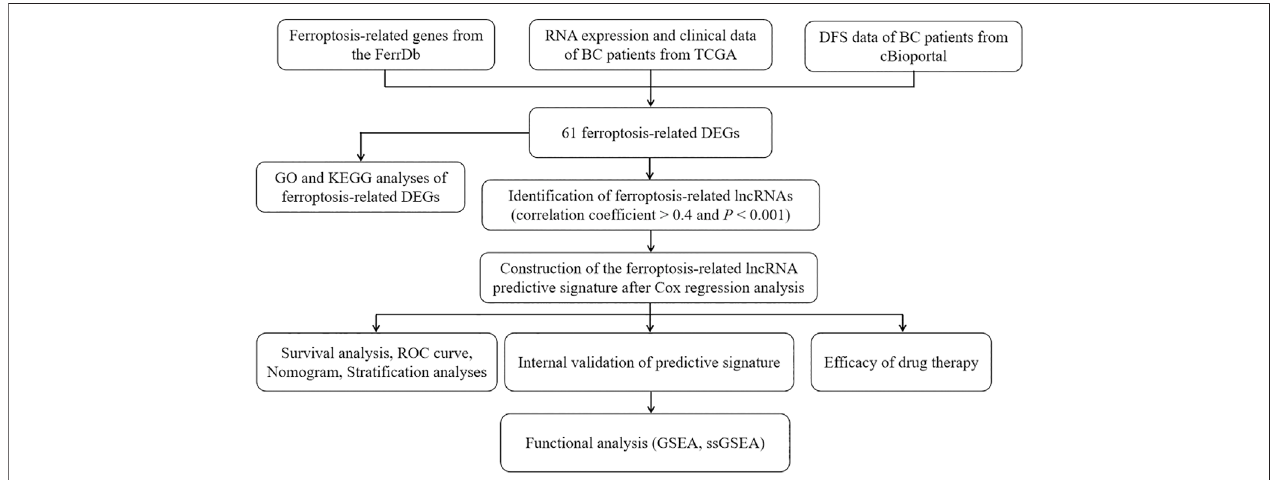
FIGURE1| The fl owchartofourresearch.BC,bladdercancer;TCGA,TheCancerGenomeAtlas;DFS,disease-freesurvival;DEGs,differentiallyexpressedgenes; GO, Gene Ontology; KEGG, Kyoto Encyclopedia of Genes and Genomes; lncRNAs, long noncoding RNAs; ROC, receiver operating characteristic; GSEA, gene enrichment analysis; ssGSEA, single-sample gene set enrichment